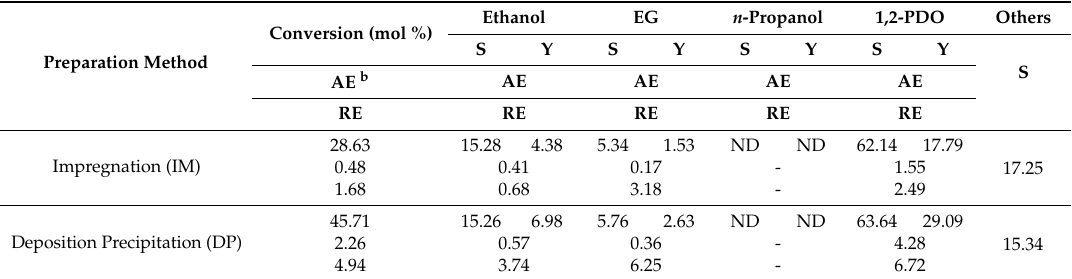
Table 2. Effect of preparation method on the activity of Ni/Ce–Mg catalysts a,b